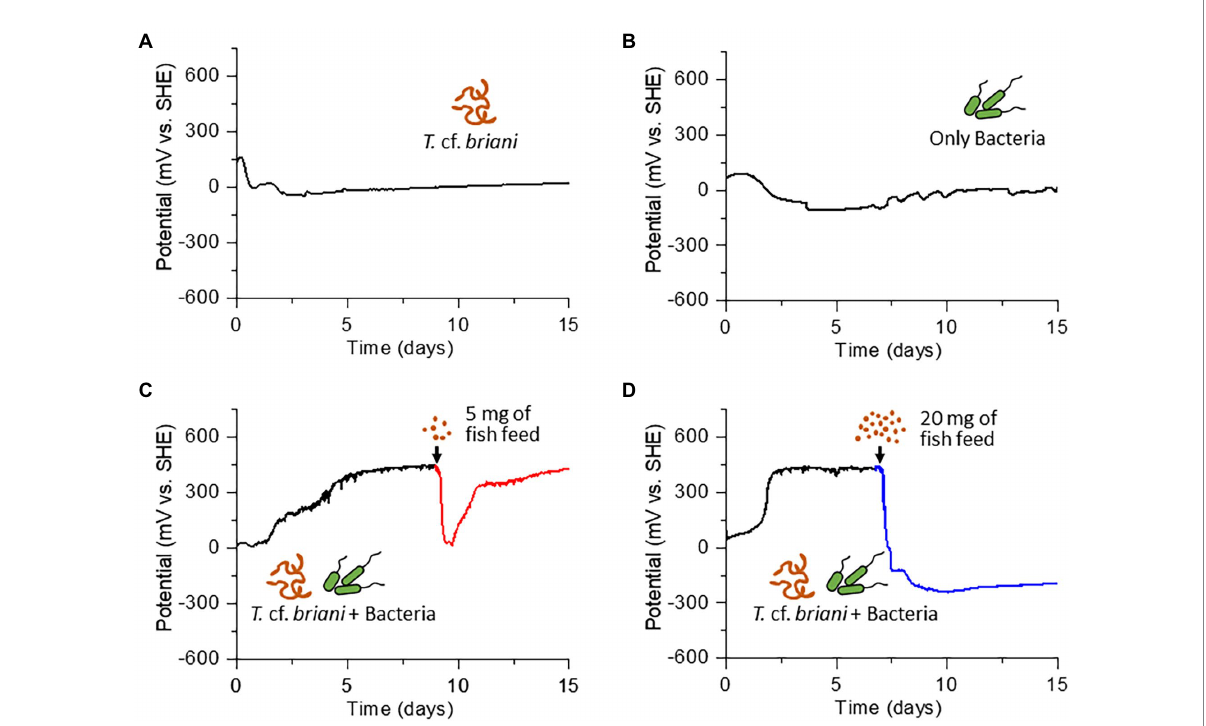
FIGURE 2 Time courses of open circuit potential measurements for (A) sediment containing only oligochaetes, (B) sediment containing only sediment microorganisms, and (C,D) sediment containing both oligochaetes and sediment microorganisms. The arrow in (C) and (D) indicates the time at which 5 and 20 mg of fish diet, respectively, was added to the electrochemical